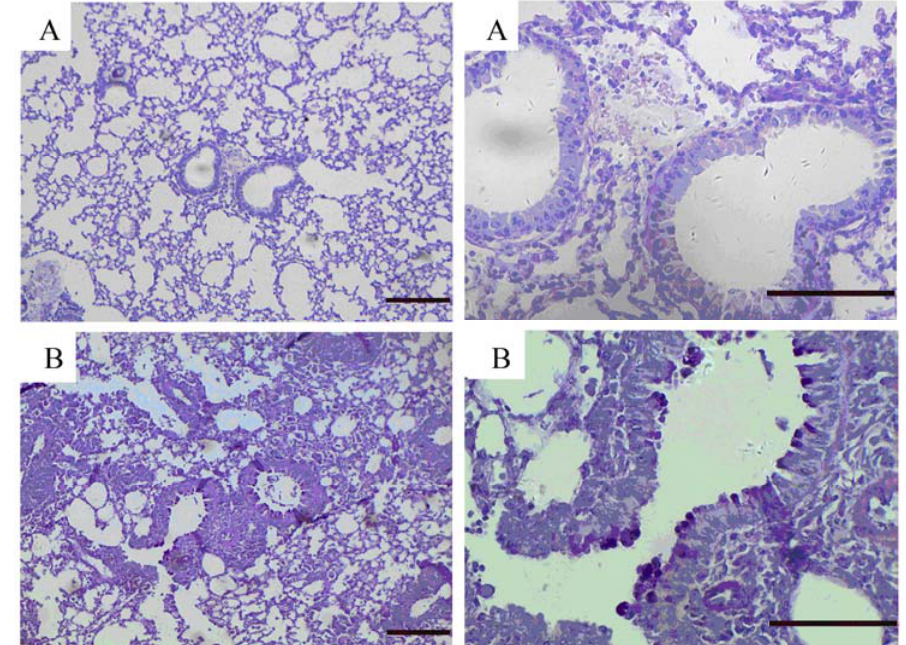
Figure 6. Effects of ginkgolide B on airway goblet cell hyperplasia and mucus production. Representative alcian blue-periodic acid-Schiff stained sections of lung from: ( A ) PBS-challenged mice; ( B ) OVA-challenged mice; ( C ) OVA-challenged mice treated with ginkgolide B. The left panel is magnified × 100, scale bars = 100 μ m. The right panel is magnified × 400, scale bars = 50 μ